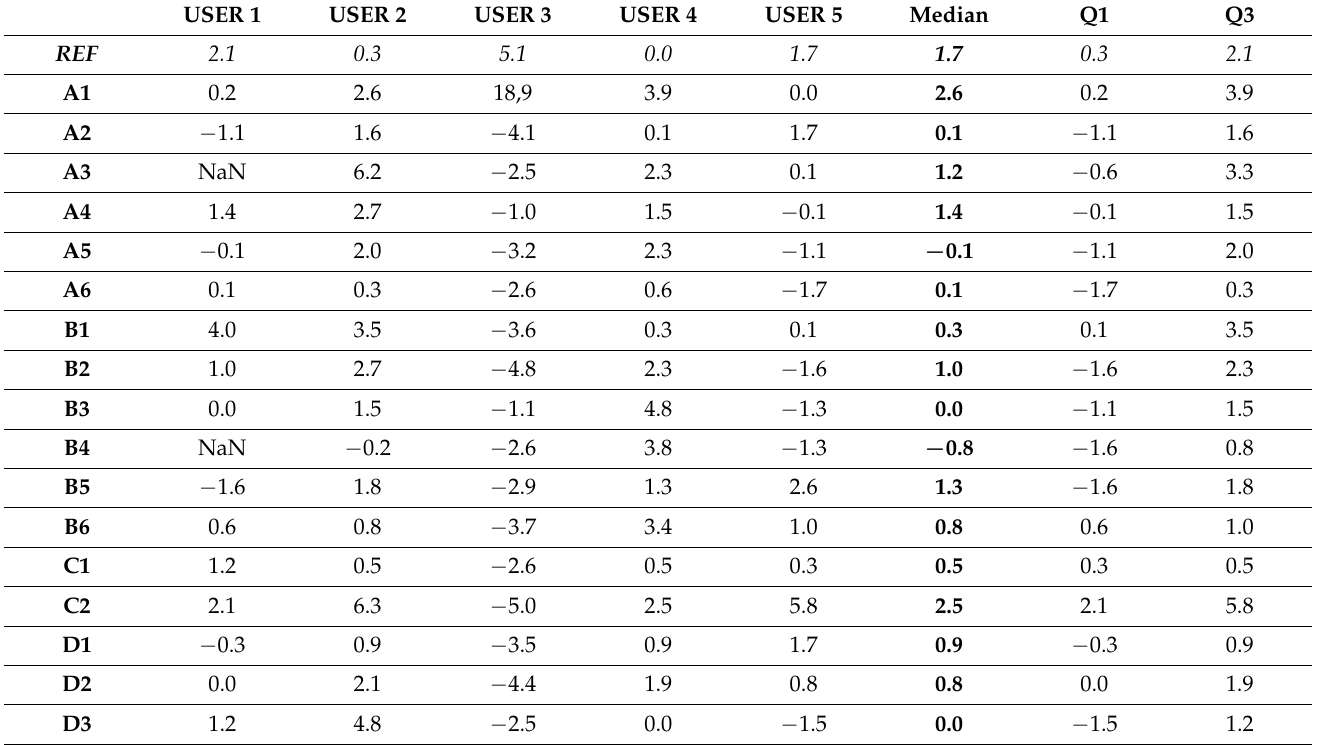
Table A7. Spatial asymmetry: Users’ asymmetry in stride